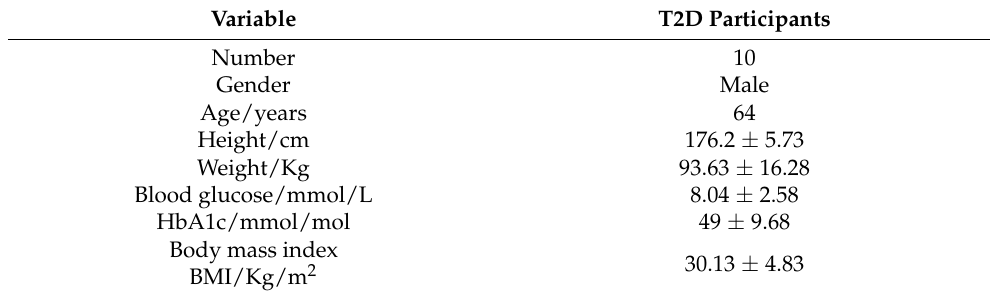
Table 3. Characteristics of the participants in this study. Data are means ± SD. T2D participants ( n =